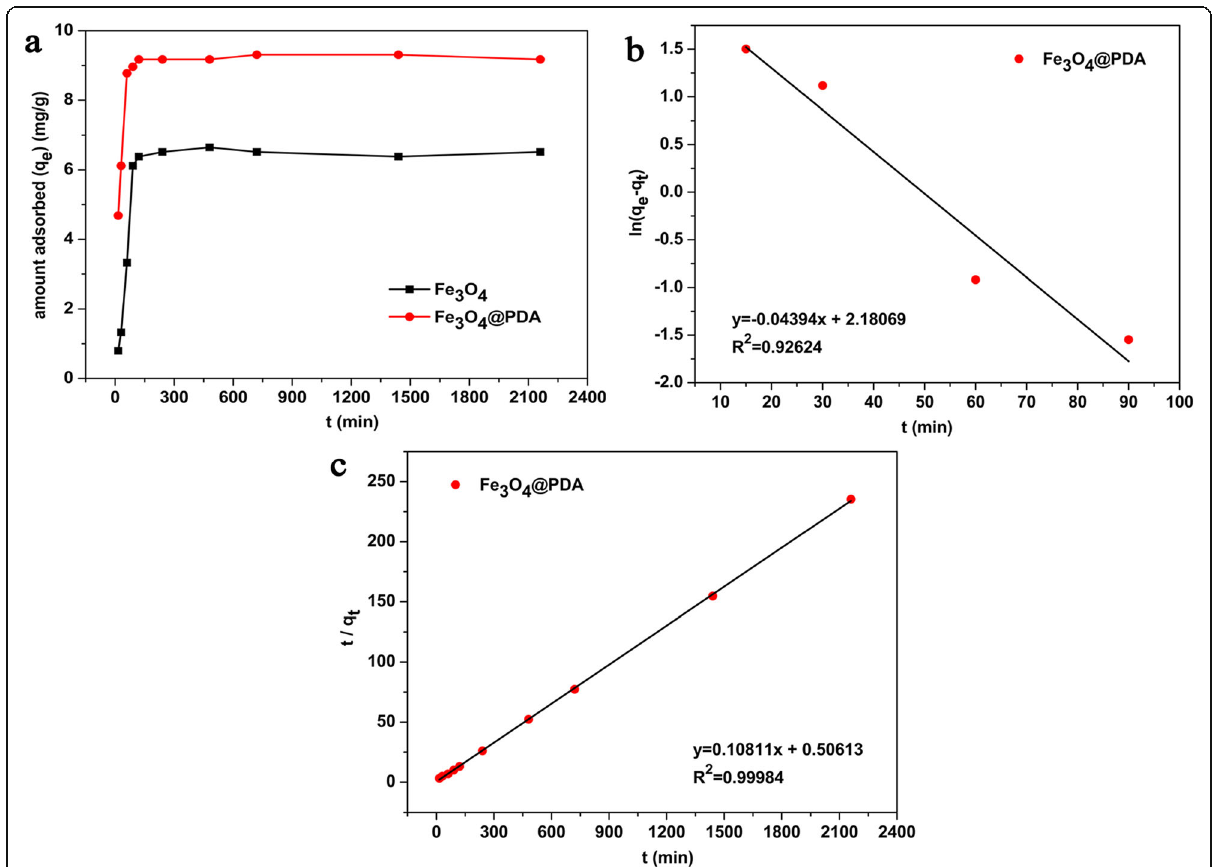
Fig. 4 a Effect of the reaction time on the adsorption capacity of adsorbents (Fe 3 O 4 and Fe 3 O 4 @PDA), b pseudo-first-order kinetics, and c pseudo-second-order kinetics of